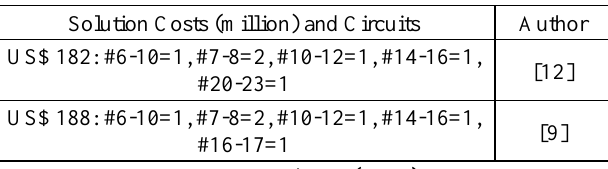
Table 5: IEEE-24/41 test system - Other authors'